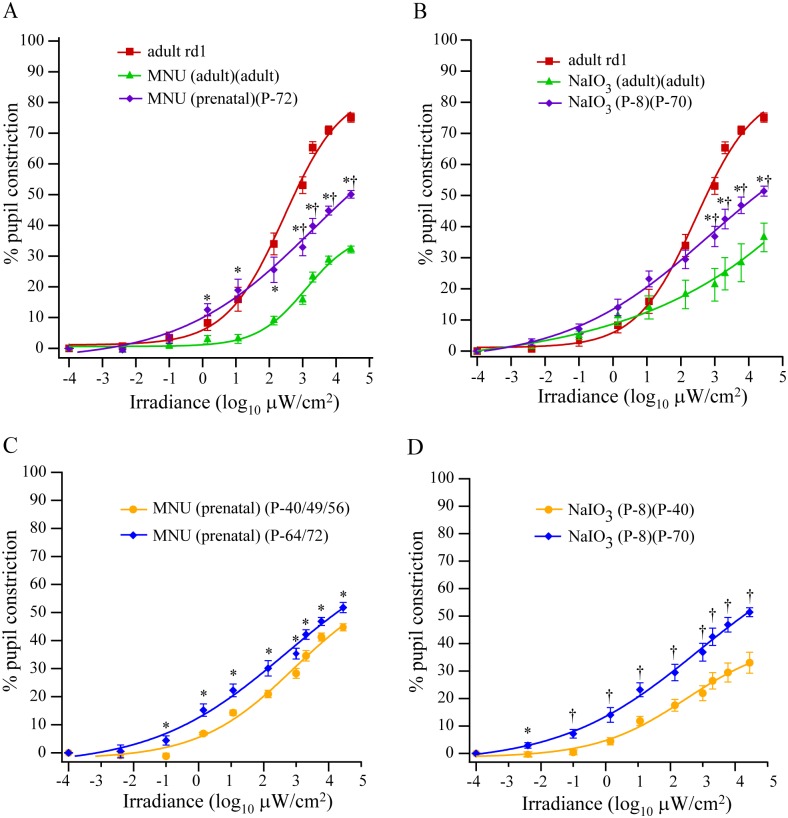
Photoreceptor loss induced during development resulted in partial rescue of PLR at higher irradiances.A) PLR in adult (P-72) mice that were injected with MNU prenatally (5 mg/kg i/p at embryonic day 16; n = 5 mice). The 2 parentheses in the label show animal ages when the drug was injected and PLR was recorded, respectively. PLRs of mice injected with MNU during adulthood and of adult rd1 mice are replotted from Fig 1B for comparison. A mixed ANOVA with repeated measures on irradiance showed significant differences among the 3 groups (F2,18 = 60.7, P <<0.0001). A post hoc test using Bonferroni correction showed that the PLR in MNU (prenatal)(P-72) animals was significantly higher than in MNU (adult)(adult) animals (P = 0.0002), but significantly lower than the adult rd1 mice (P = 0.001). A pairwise comparison at each irradiance revealed that the PLR in MNU (prenatal)(P-72) mice was similar to that in MNU (adult)(adult) at <1 μW/cm2, but significantly higher at irradiances >1 μW/cm2. The PLR in MNU (prenatal)(P-72) mice was similar to that in adult rd1 mice at <103 μW/cm2, but significantly lower at irradiances >103 μW/cm2. * P ≤0.005 for MNU (prenatal) versus MNU (adult); †P <0.0001 for MNU (prenatal) versus adult rd1. B) PLR in adult (P-70) mice that were injected with NaIO3 at P-8 (60 mg/kg; i/p; n = 6 mice). PLRs of mice injected with NaIO3 during adulthood and of adult rd1 mice are replotted from Figs 2A and 1B, respectively, for comparison. A mixed ANOVA with repeated measures on irradiance showed significant differences among the 3 groups (F2,17 = 14.3; P = 0.0003). A post hoc test using Bonferroni correction showed that the PLR in both rd1 and NaIO3 (P-8)(P-70) mice was significantly higher than the NaIO3 (adult)(adult) mice (P = 0.0002 and 0.038, respectively), while the PLR in rd1 mice was similar to that in NaIO3 (P-8)(P-70) mice (P = 0.098). Pairwise comparisons at individual irradiances revealed that PLR was similar in all 3 groups at irradiances <103 μW/cm2. However, at >103 μW/cm2, the PLR in NaIO3 (P-8)(P-70) mice was significantly higher than in NaIO3 (adult)(adult) mice (P = 0.012 at 103 μW/cm2 to P = 0.002 at the highest irradiance) but significantly lower than in rd1 mice (P = 0.006 at 103 μW/cm2 to P = 0.00001 at the highest irradiance). * P ≤0.05 for NaIO3 (P-8)(P-70) versus NaIO3 (adult)(adult); †P <0.005 for NaIO3 (P-8)(P-70) versus rd1 mice. C) In mice injected prenatally with MNU, the PLR recorded during adulthood (P-64 or P-72) was significantly higher than during development (P-40, P-49, or P-56) (F1,8 = 12.6, P = 0.008, n = 5 mice; two-way ANOVA with repeated measures). A pairwise comparison revealed significant differences at irradiances ≥0.1 μW/cm2. *P <0.05. D) In mice injected at P-8 with NaIO3, the PLR recorded during adulthood (P-70) was significantly higher than during development (P-40) (F1,10 = 18.02, P = 0.002; n = 6 mice; two-way ANOVA with repeated measures). A pairwise comparison revealed significant differences at all irradiances. *P <0.05; †P <0.01.